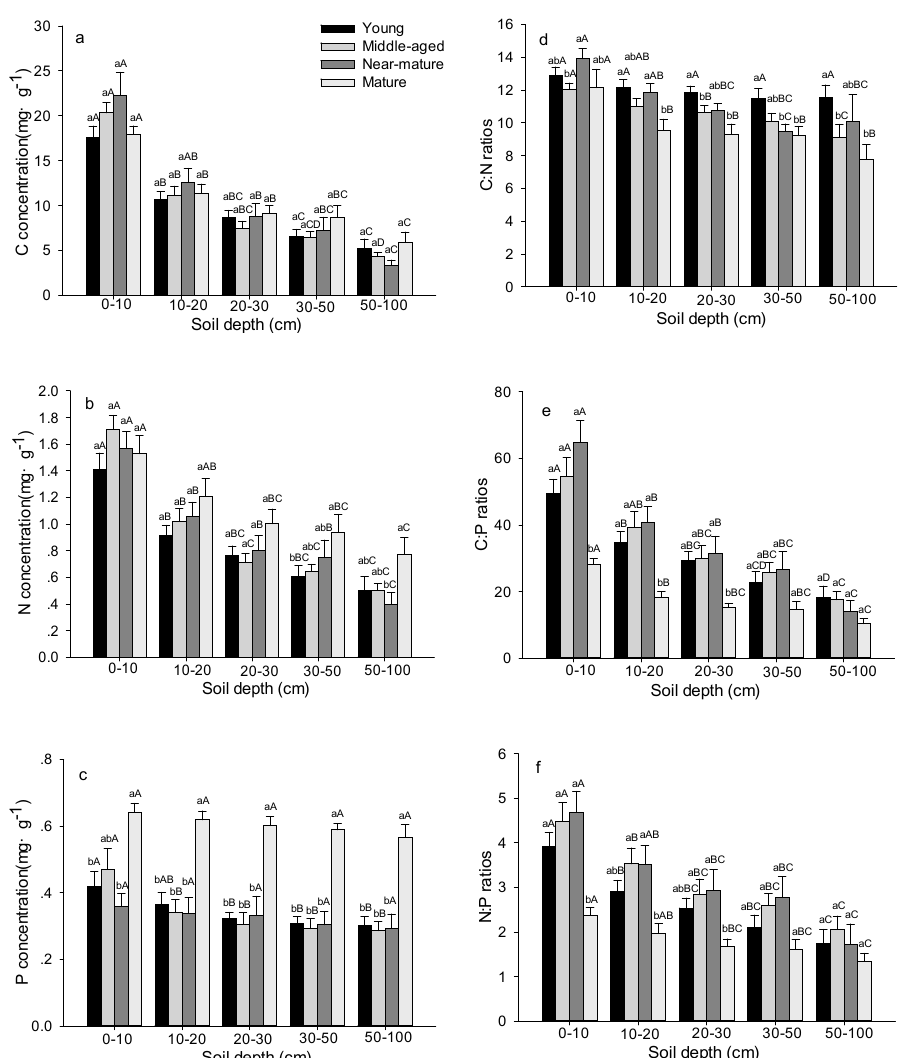
Figure 4. C, N, and P stoichiometric characteristics in soil layer in Quercus variabilis natural forest of different age classes (Means ± SE, n = 8, 6, 3 and 3 for young, middle-aged, near-mature and mature stands, respectively). ( a ) C concentration in soil layer of different age classes; ( b ) N concentration in soil layer of different age classes; ( c ) P concentration in soil layer of different age classes; ( d ) C:N ratio in soil layer of different age classes; ( e ) C:P ratio in soil layer of different age classes; ( f ) N:P ratio in soil layer of different age classes. Different small letters indicated significant difference in the same indicators among different forest age classes, and different capital letters indicated significant difference among different components in the same forest age class ( p < 0.05).